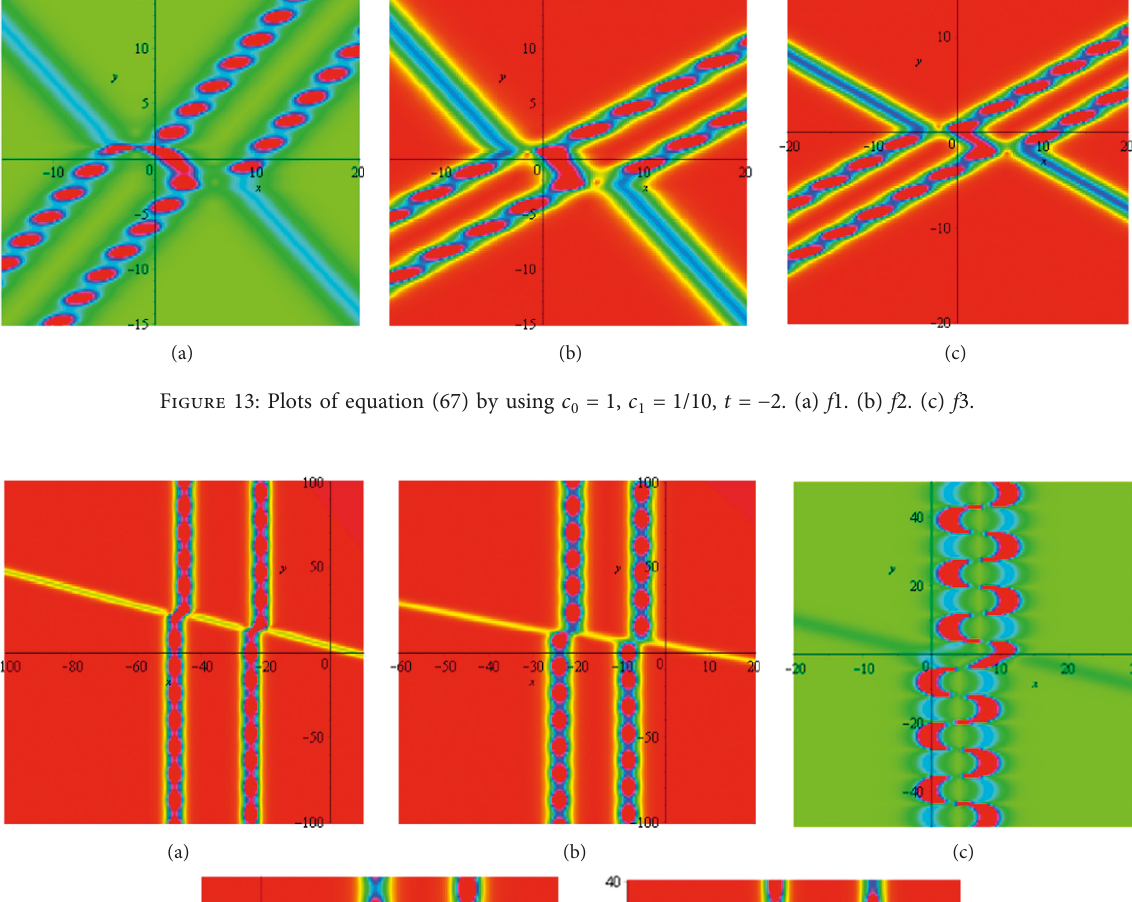
� 1 , σ � 1 , κ � 1/3 , σ 1 1 1